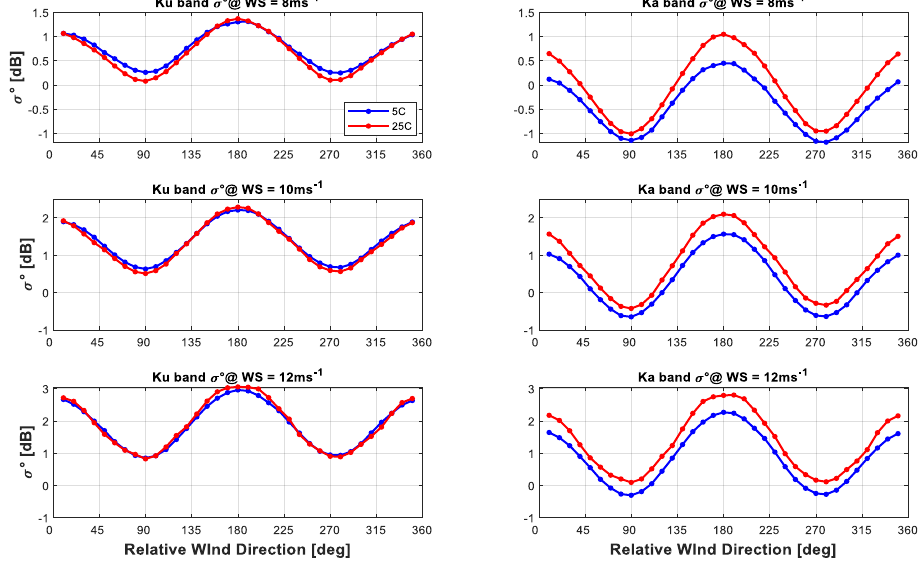
Figure 22. SST impacts on KuPR and KaPR σ 0 model functions at different WS values at an EIA of 18°.